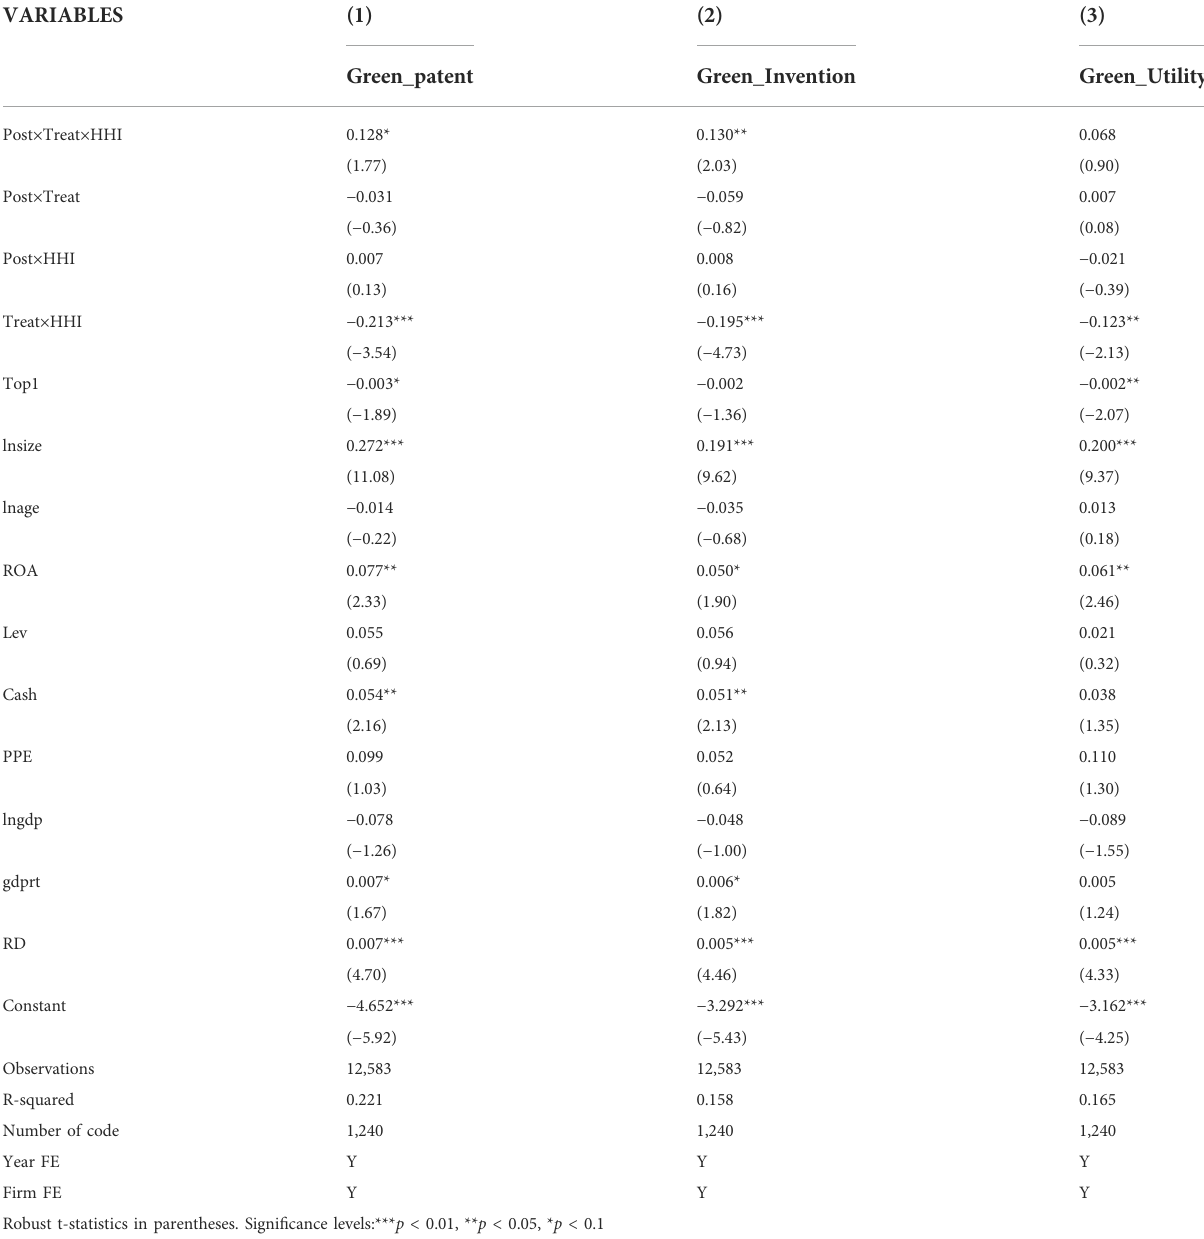
TABLE 5 Impact of low-carbon city pilot policy and market competition on green innovation.